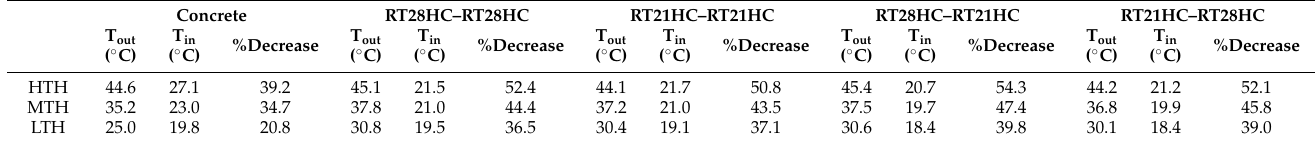
Table 2. Peak outdoor (sample base) to indoor (sample top) temperatures percentage